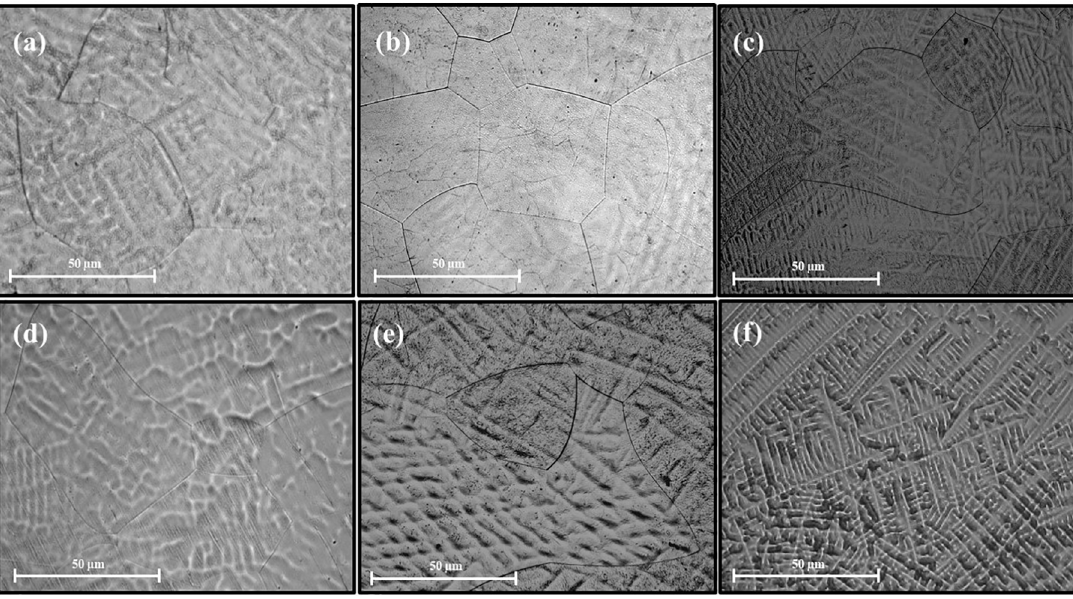
The Vickers hardness values of the as–cast Ti-12Mo-xNb alloys (226–358 HV) were higher than that of CP Ti (199 HV). The Ti-12Mo and Ti-12Mo-3Nb alloys presented higher hardness values than that of as–cast Ti-6Al-4V alloy (294HV). Figure 4 shows the values of the Young’s modulus for the alloys as a function of the increase of niobium in the as–cast Ti-12Mo-xNb alloys.